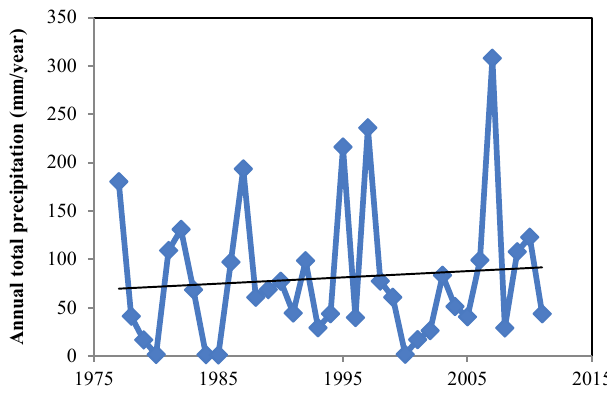
Fig. 2 Annual total precipitation in